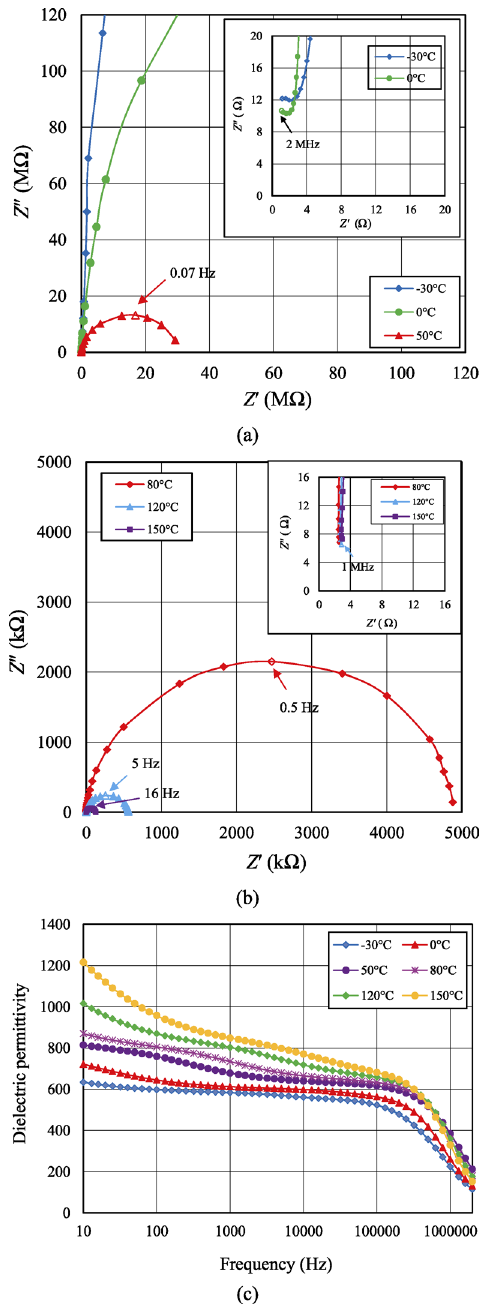
Fig. 8 (a, b) Complex impedance plots, (c) dielectric permittivity versus frequency at a few selected temperatures in the range from –30 to 150 ℃ , for a multilayer varistor sintered at 1050 ℃